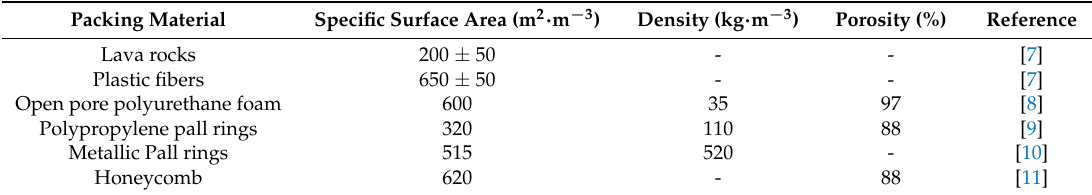
Table 1. Packing material